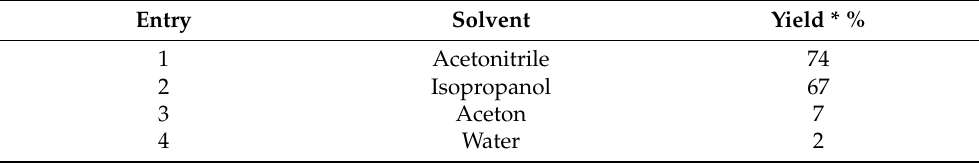
Table 1. Effect of solvents on the oxidation of benzyl alcohol. Entry